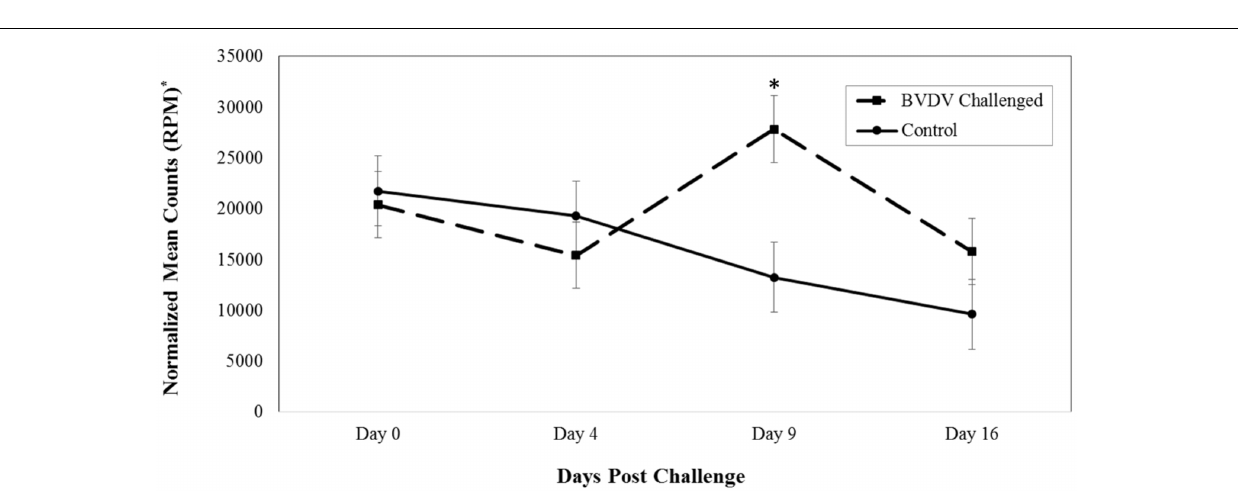
FIGURE 1 | Interaction of time and challenge status for bta-miR-423-5p ( P = 0.008). ∗ RPM stands for reads per million. Dashed line corresponds to cattle challenged with bovine viral diarrhea virus (BVDV). Solid line corresponds to control animals.